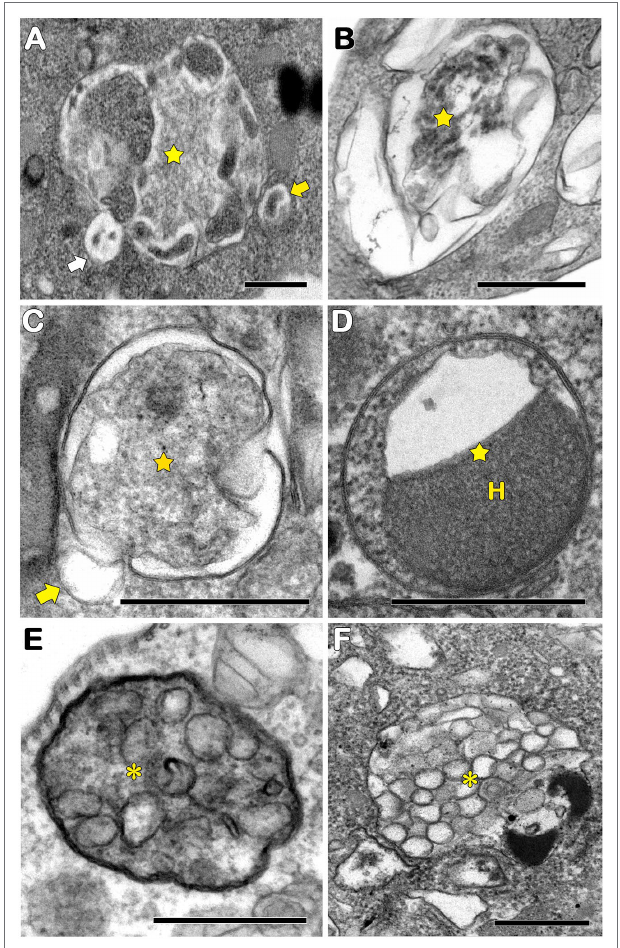
FIGURE 2 | Transmission electron microscopy analysis of autophagosomes in pathogenic protozoa. (A–C,E) Trypanosoma cruzi . (D,F) Trichomonas vaginalis . (A–D) Autophagosomes with cargo in different levels of degradation (stars). Small vesicles in close contact with autophagosomal membrane were also observed (arrows). (E,F) Multivesicular bodies (asterisks). H, hydrogenosome. Bars = 0.5 μ m.